Question: Which visualization type does this figure use?
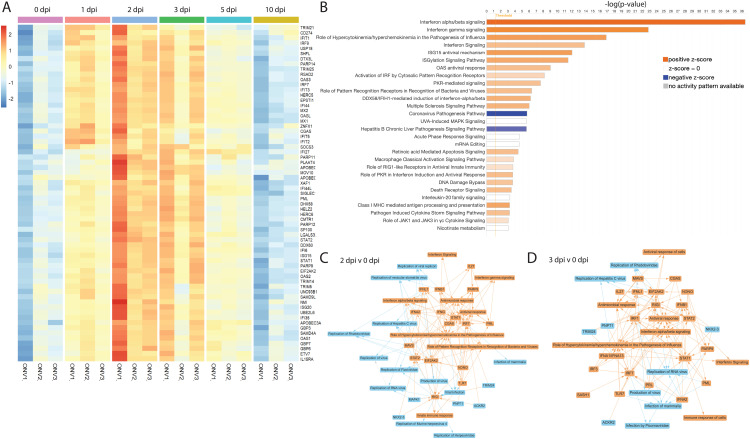
Answer: heatmap